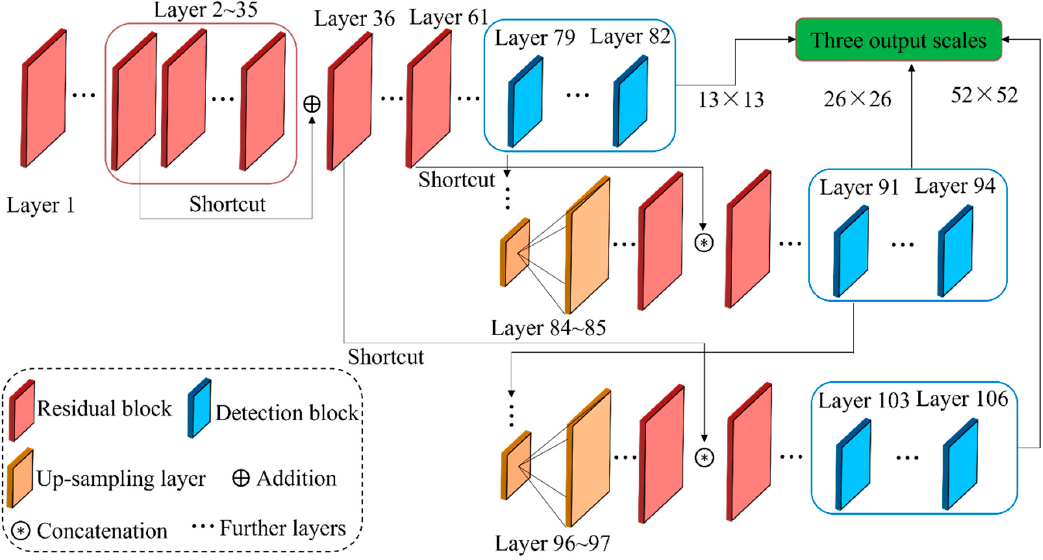
Figure 8. The YOLOv3 architecture with the 3-scale prediction mechanism.